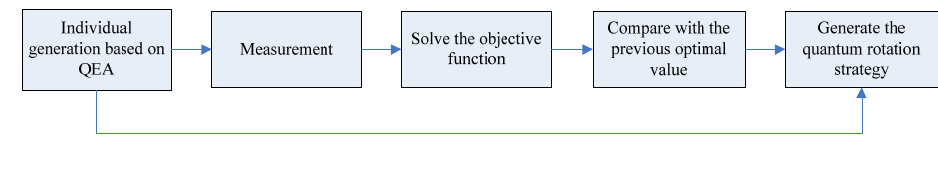
Figure 6. QEA optimization procedure.